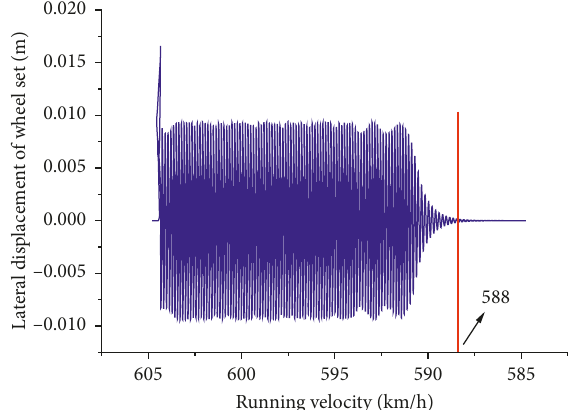
Figure 4: Nonlinear critical speed of the proposed vehicle model.